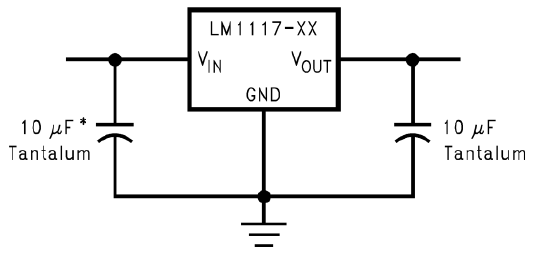
Figure 19. Conversion circuit for 5 V (V IN ) to 3.3 V (V OUT ).